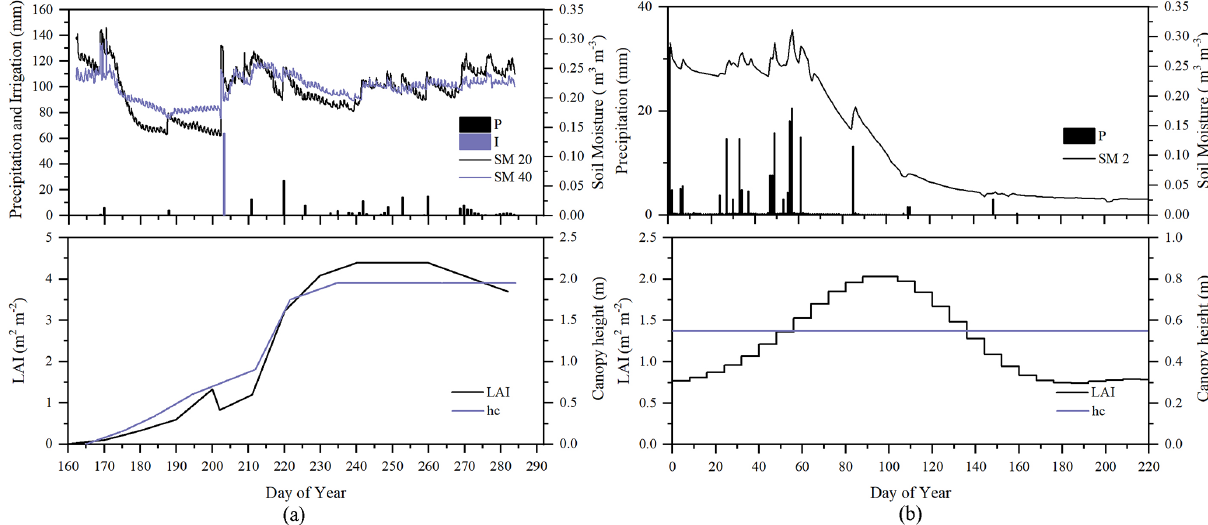
Figure 2. Seasonal variation in precipitation ( P ); irrigation ( I ); soil moisture at 2 (SM 2), 20 (SM 20), and 40cm depth (SM 40); leaf area index (LAI); and canopy height ( h c ) for (a) maize cropland at Yangling station and (b) grassland at the Vaira Ranch (US-Var) FLUXNET site.